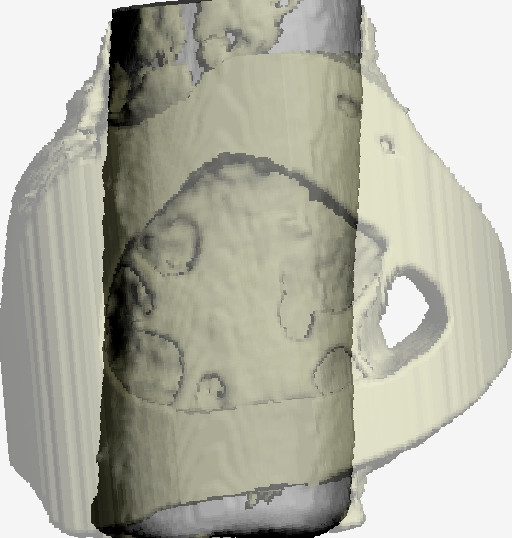
3a and 3b. 3-D microCT view of a titanium implant (a) and illustration of defined peri-implant VOIs (b).)